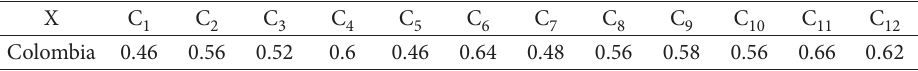
Table 5. Ideal conditions for entrepreneur